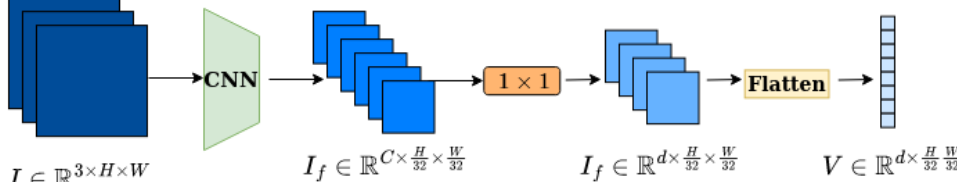
decoder, the frame passes through the same transformations until it is fed into the encoder/decoder blocks. Encoder and decoder inputs have the same